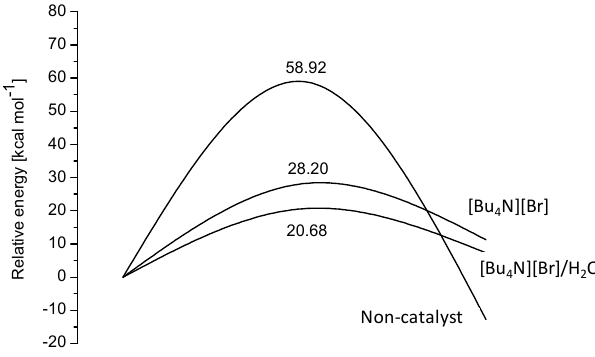
Figure 2. Comparison of relative energy for the rate-determining step for the fixation of with ethylene oxide [81]. Acknowledgements to be used by RSC authors. CO 2